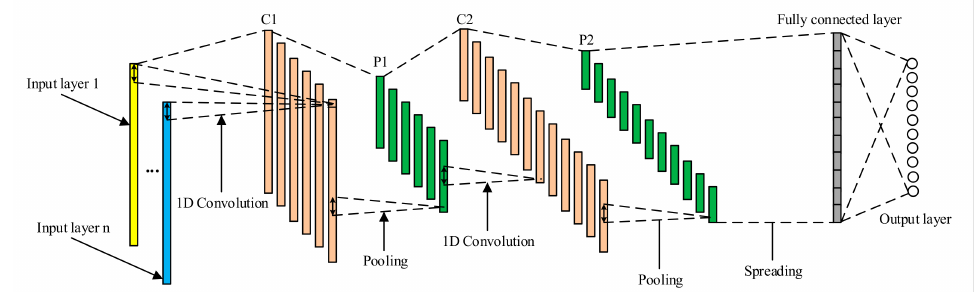
Figure 1. The structure of the Multi-Dimension Input convolutional neural network. C1 and C2 represent the convolutional layer 1 and convolutional layer 2, respectively, and P1 and P2 represent the pooling layer 1 and pooling layer 2,